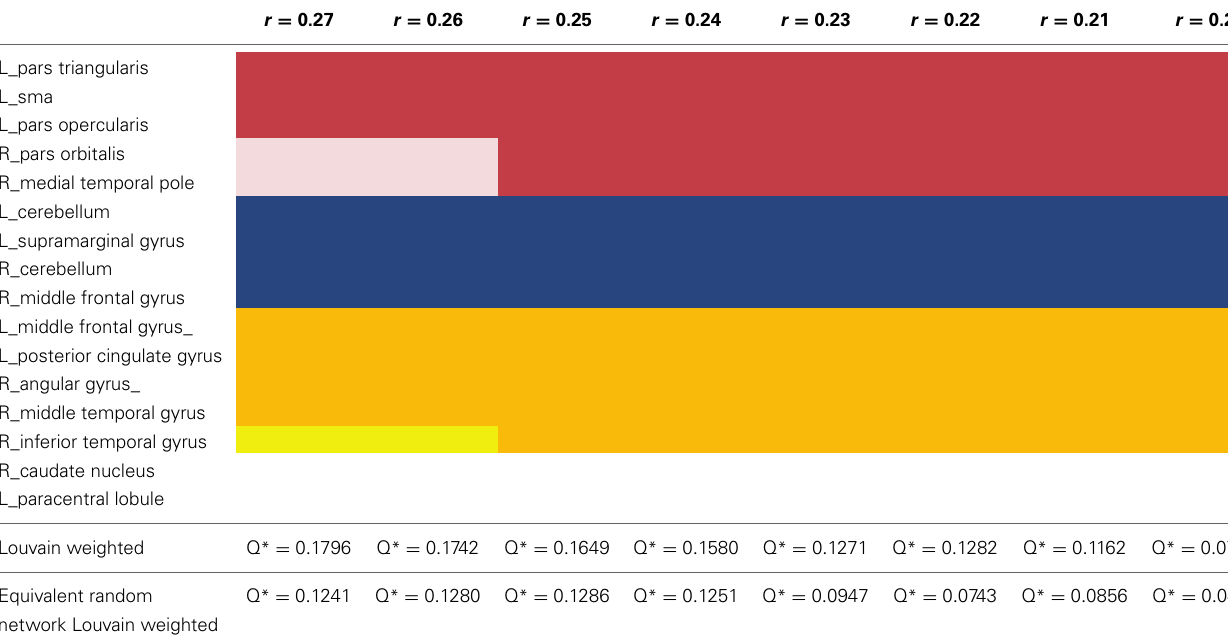
The nodes of the “language module” are shaded red, respectively rose, the nodes of the “connector module” are shaded blue, and the nodes of the “DMN module” are shaded yellow. Additionally, the second lowest row shows the Q * -values for the partition of the empirical data, the lowest row the Q * of an equivalent random network. The modularity algorithm used was the Louvain algorithm of Blondel et al.